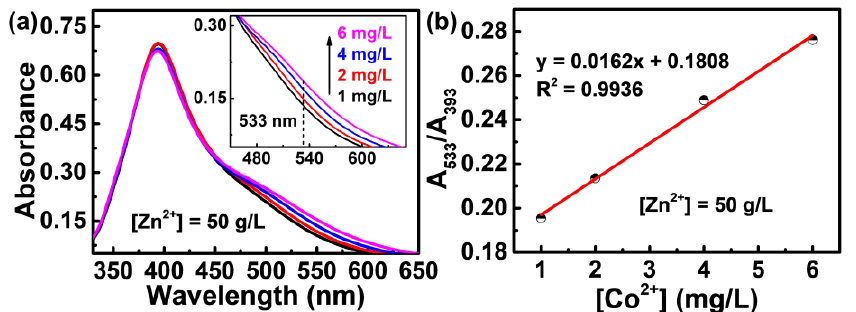
Figure 3. ( a ) UV-vis absorption spectra of PVP-AgNPs mixed with fixed 50 g/L Zn 2+ and different concentration of Co 2+ (black line: 1 mg/L, red line: 2 mg/L, blue line: 4 mg/L, pink line: 6 mg/L). The inset shows the enlarged view of 450 – 650 nm wavelength range. ( b ) The dependence of the A 533 /A 393 values of PVP-AgNPs on the increasing concentration of Co 2+ .